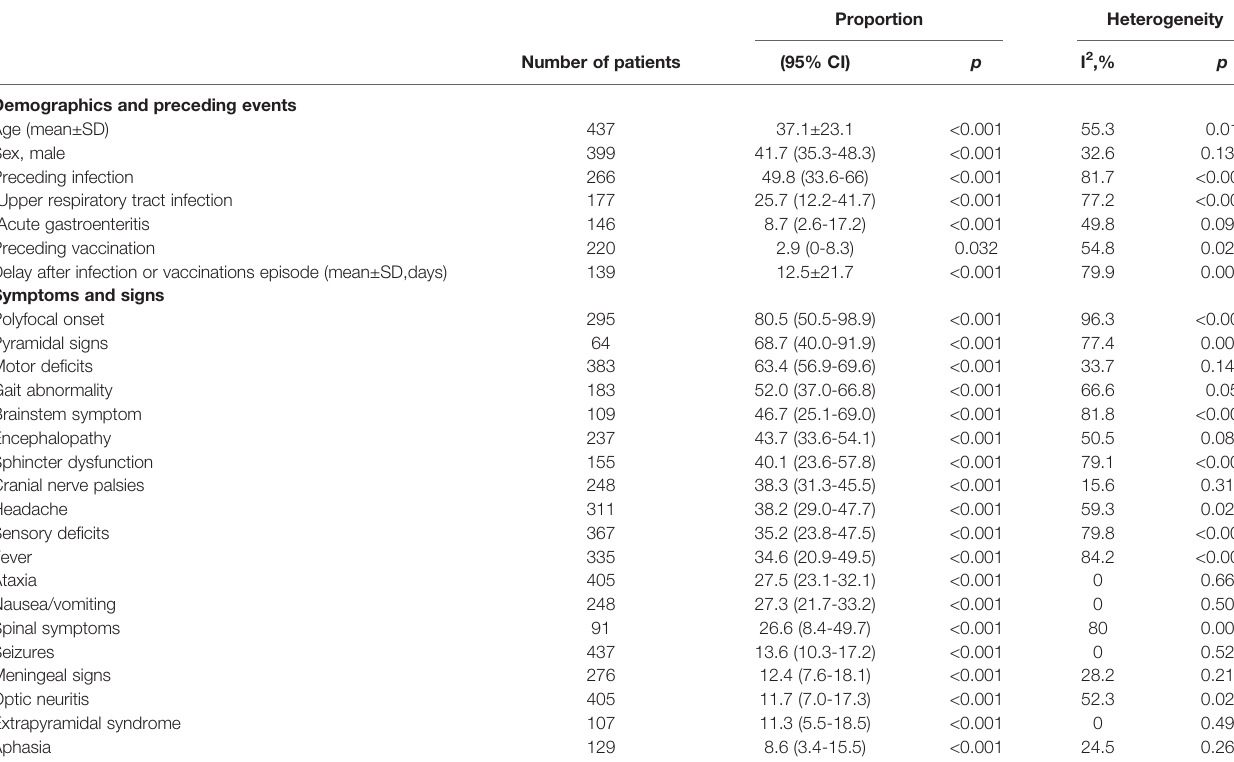
TABLE 2 | Clinical features in patients with